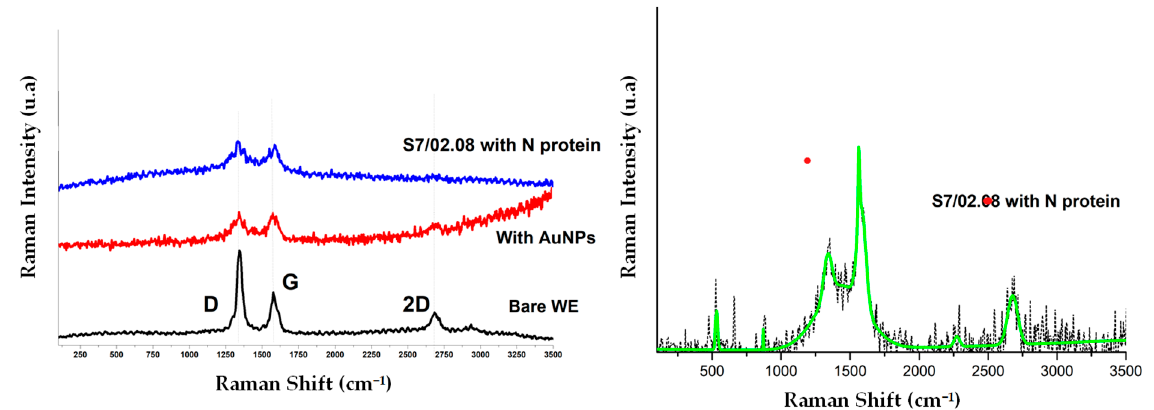
Figure 5. Raman spectra of WE: bare WE (black), with AuNPs (red) and with N-protein ( left ), with detail (blue) for S7/02.08 with N-protein ( right ).